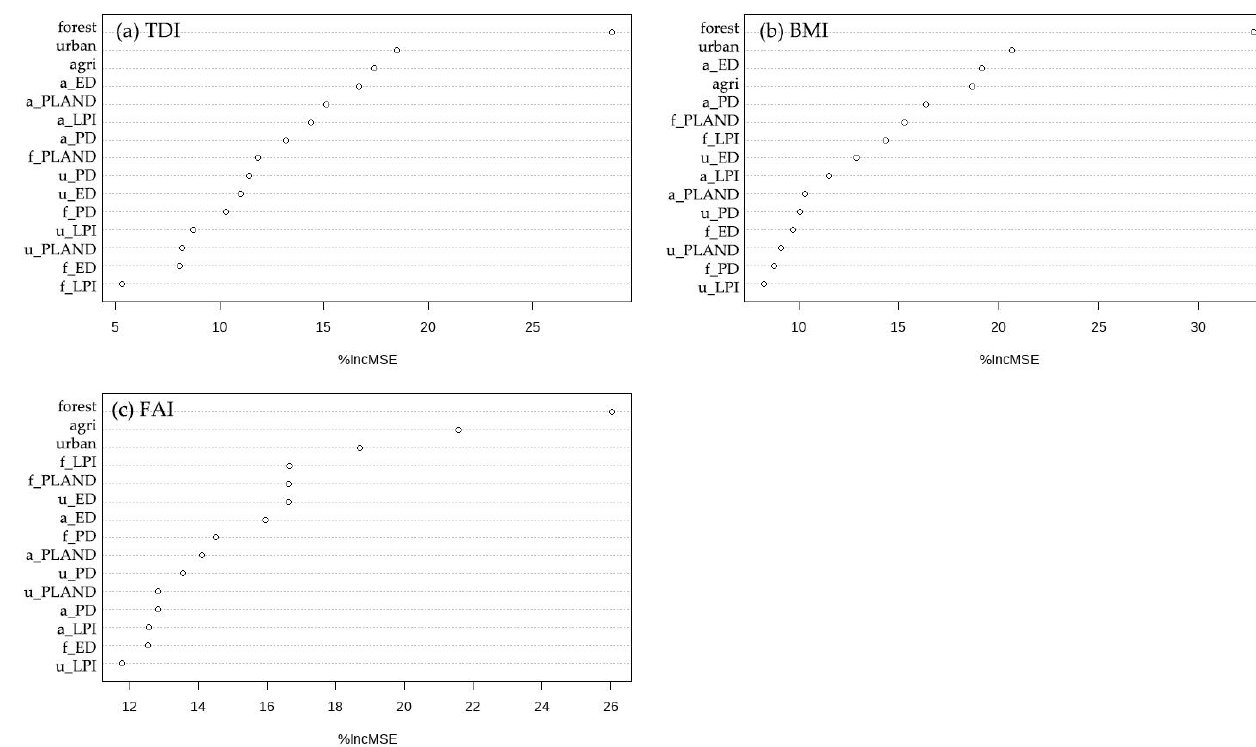
Figure 3. Relative influence of predictors based on the random forest models: ( a ) Trophic Diatom Index (TDI); ( b ) Benthic Macroinvertebrate Index (BMI); and ( c ) Fish Assessment Index (FAI). PD, patch density; ED, edge density; LPI, large patch index; PLAND, percentage of landscape. The vertical axis represents the number of variables, while the horizontal axis represents the relative influence of each variable.